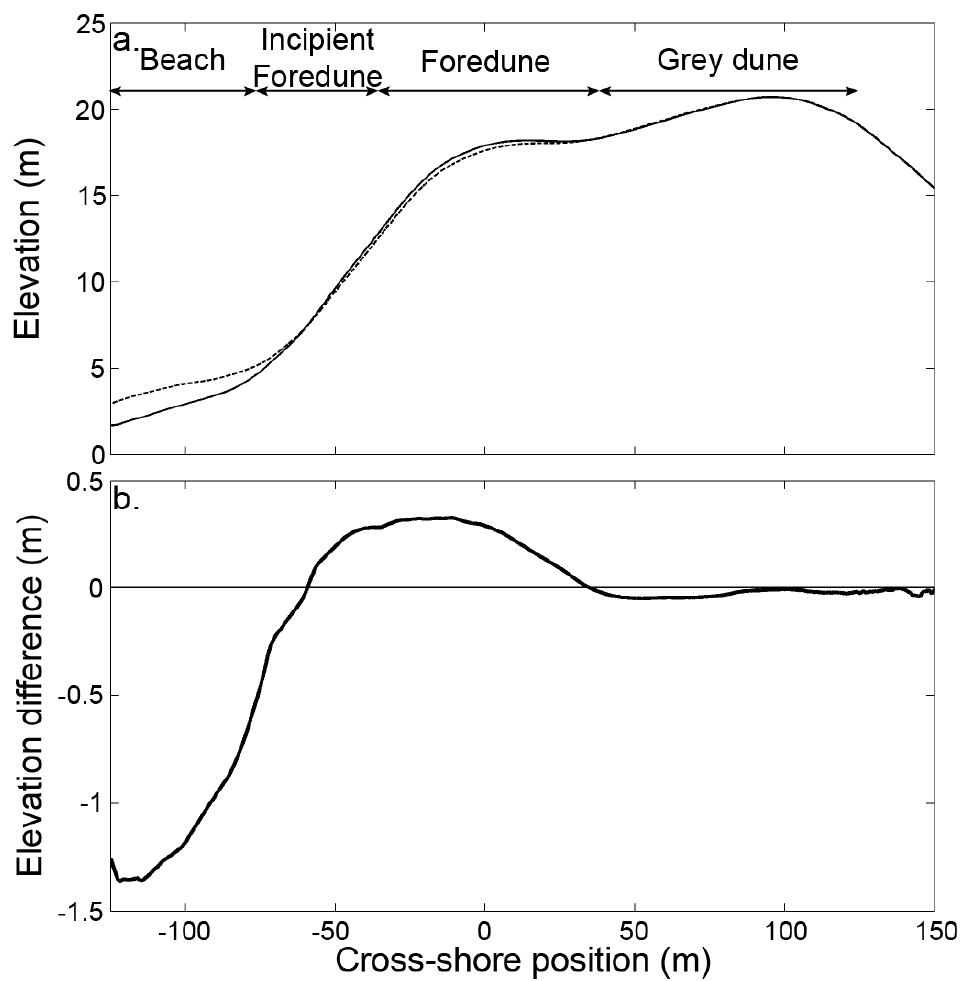
Figure 8. ( a ) 4-km alongshore-averaged beach-dune profile at Truc Vert on 9 October 2017 obtained with DP2 (dotted black line) and on 13 March 2018 obtained with DP4P (black line) with ( b ) corresponding elevation change between 9 October 2017 (survey performed with DP2) and 13 March 2018 (survey performed with DP4P).